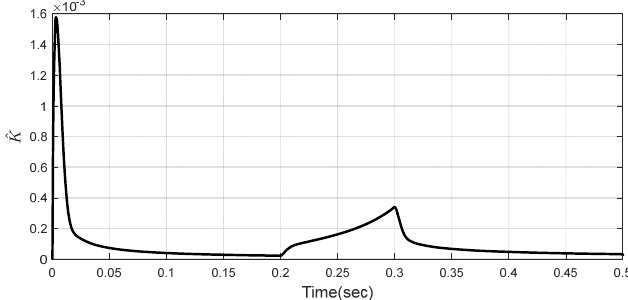
Figure 27. Adaptation gain.